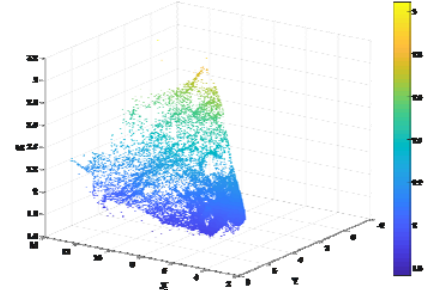
Figure 4. Local 3D information restored from the stereo pair